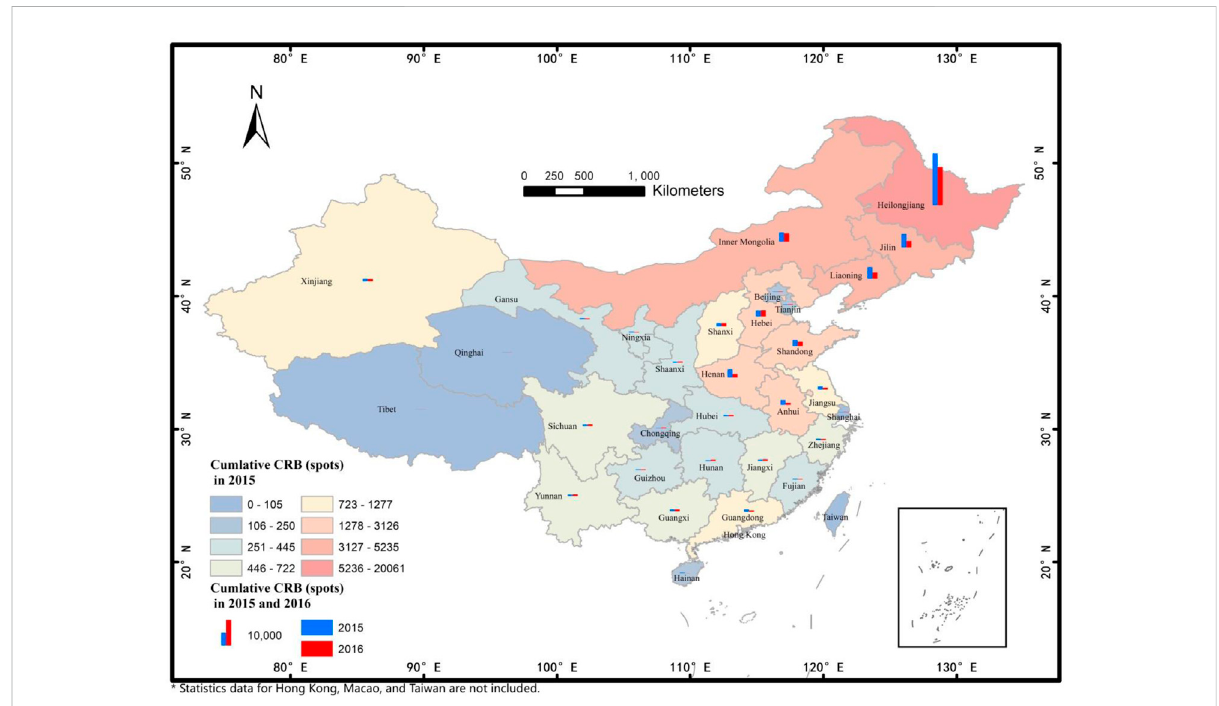
FIGURE 2 Spatial distribution of cumulative CRB spots in China (2015 and 2016) at the provincial